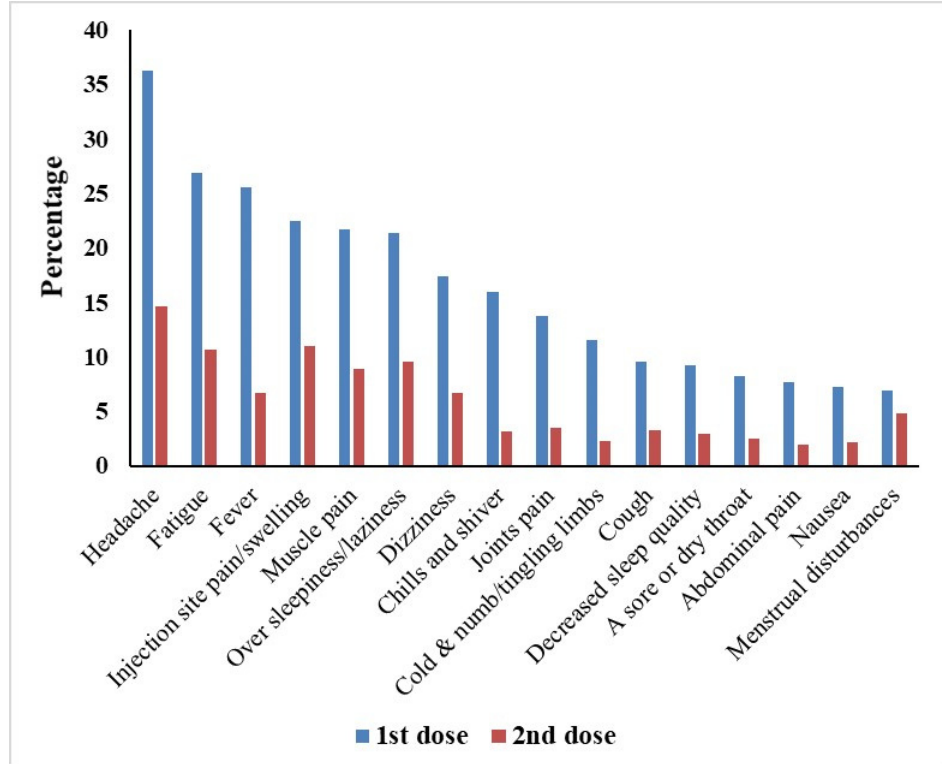
Figure 1. Most common COVID-19 vaccine side effects reported by the participants after the first and second vaccine dose ( n = 609). Table 3. COVID-19 vaccine side effects reported by the participants after the first dose of different vaccine types ( n = 609).